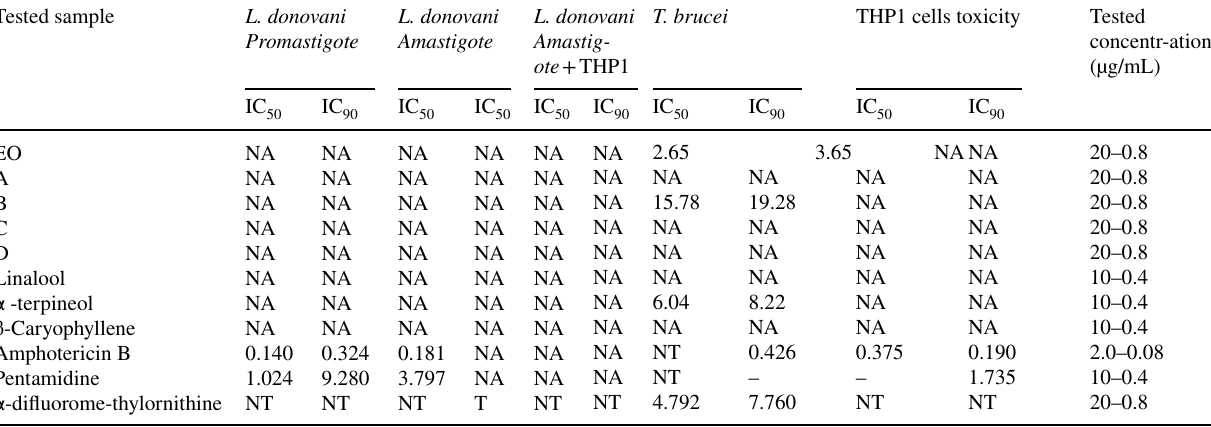
NA not active at tested concentration, NT not tested against listed